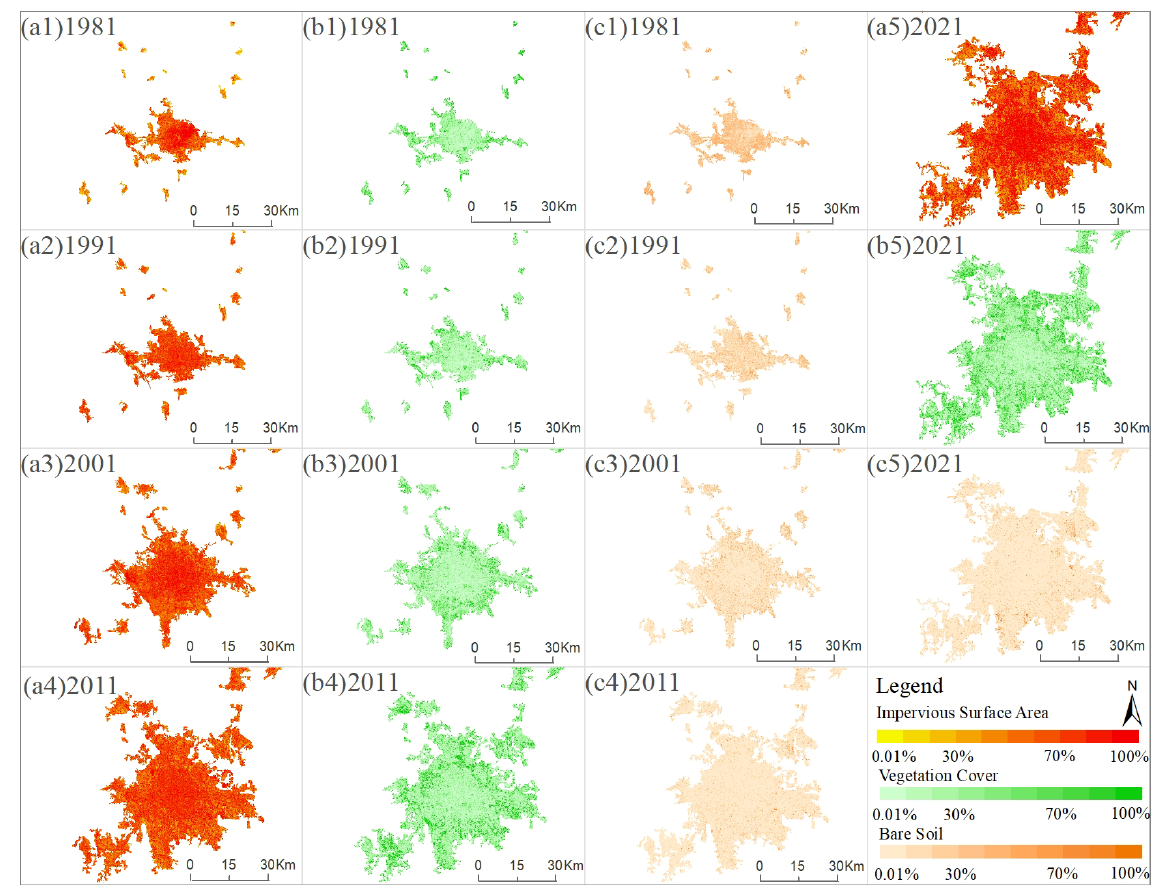
Figure 6. Urban land component in types of impervious surface area (red), vegetation cover (green), and bare soil (yellow) with values from 0.01% to 100% during the period of 1981–2021, respectively. Note: ( a1 – a5 , b1 – b5 , c1 – c5 ) represented the land component types of impervious surface area, vegetation cover, and bare soil in each year, respectively.